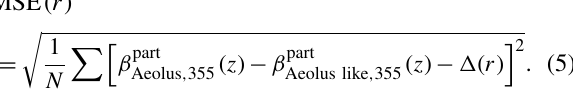
Figure 2. Scatterplot of δ rine and anthropogenic particles obtained from the literature (see Table